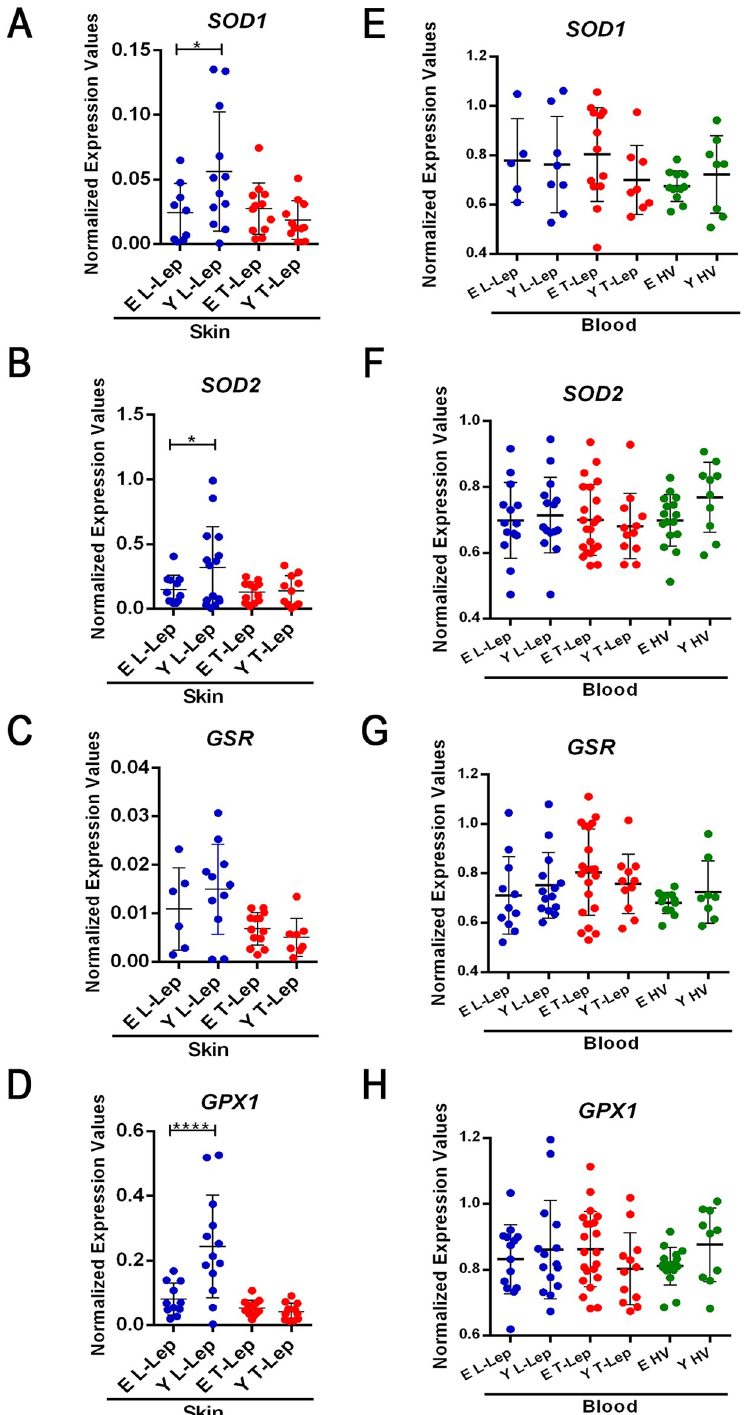
Fig 4. Gene expression analysis of antioxidant enzymes in whole blood and skin lesions. Quantitative PCR (qPCR) evaluation of mRNA levels of SOD1 ( A and E ), SOD2 ( B and F ), GSR ( C and G ) and GPX1 ( D and H ) was performed in whole blood and skin lesion samples. Each circle represents one individual. Horizontal bars represent the mean values ± SD. Data analysis was performed using ordinary one-way ANOVA followed by Holm-Sidak’s multiple comparison test ( A , B , and G ). Kruskal-Wallis test followed by Dunn’s multiple comparison post-test was used for the analysis of non-normally distributed and/or heteroscedastic data ( C ). Variation in number of individuals for each